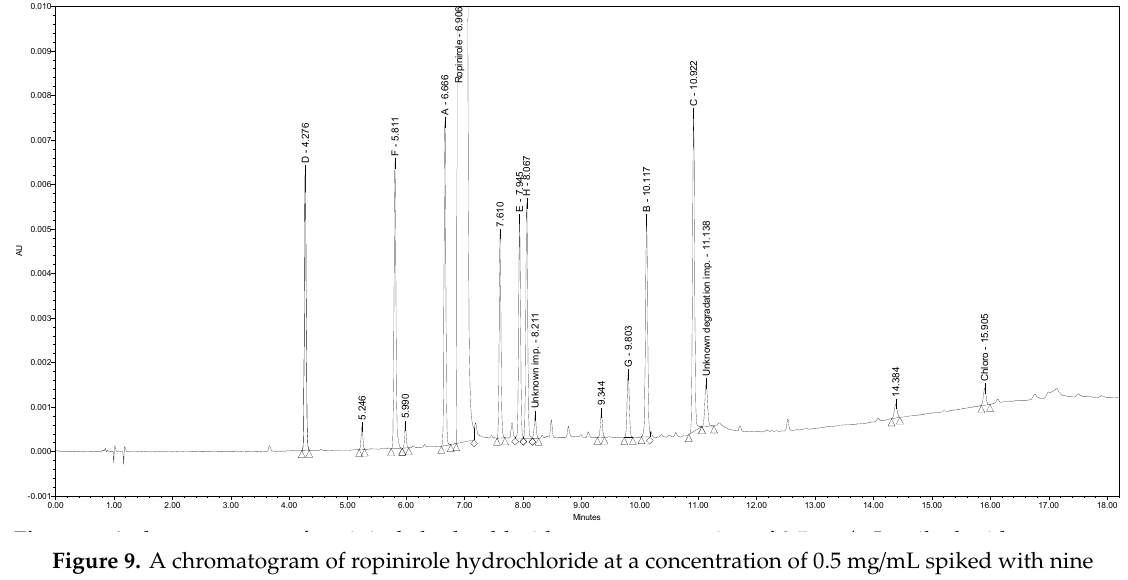
Figure 8. A chromatogram of ropinirole hydrochloride at a concentration of 0.5 mg/mL spiked with nine process-related impurities at the 0.2% level, including unknown impurity present in the sample (t R ≈ 9 min) and unknown degradation impurity (t R ≈ 13 min), obtained using chromatographic conditions 1.